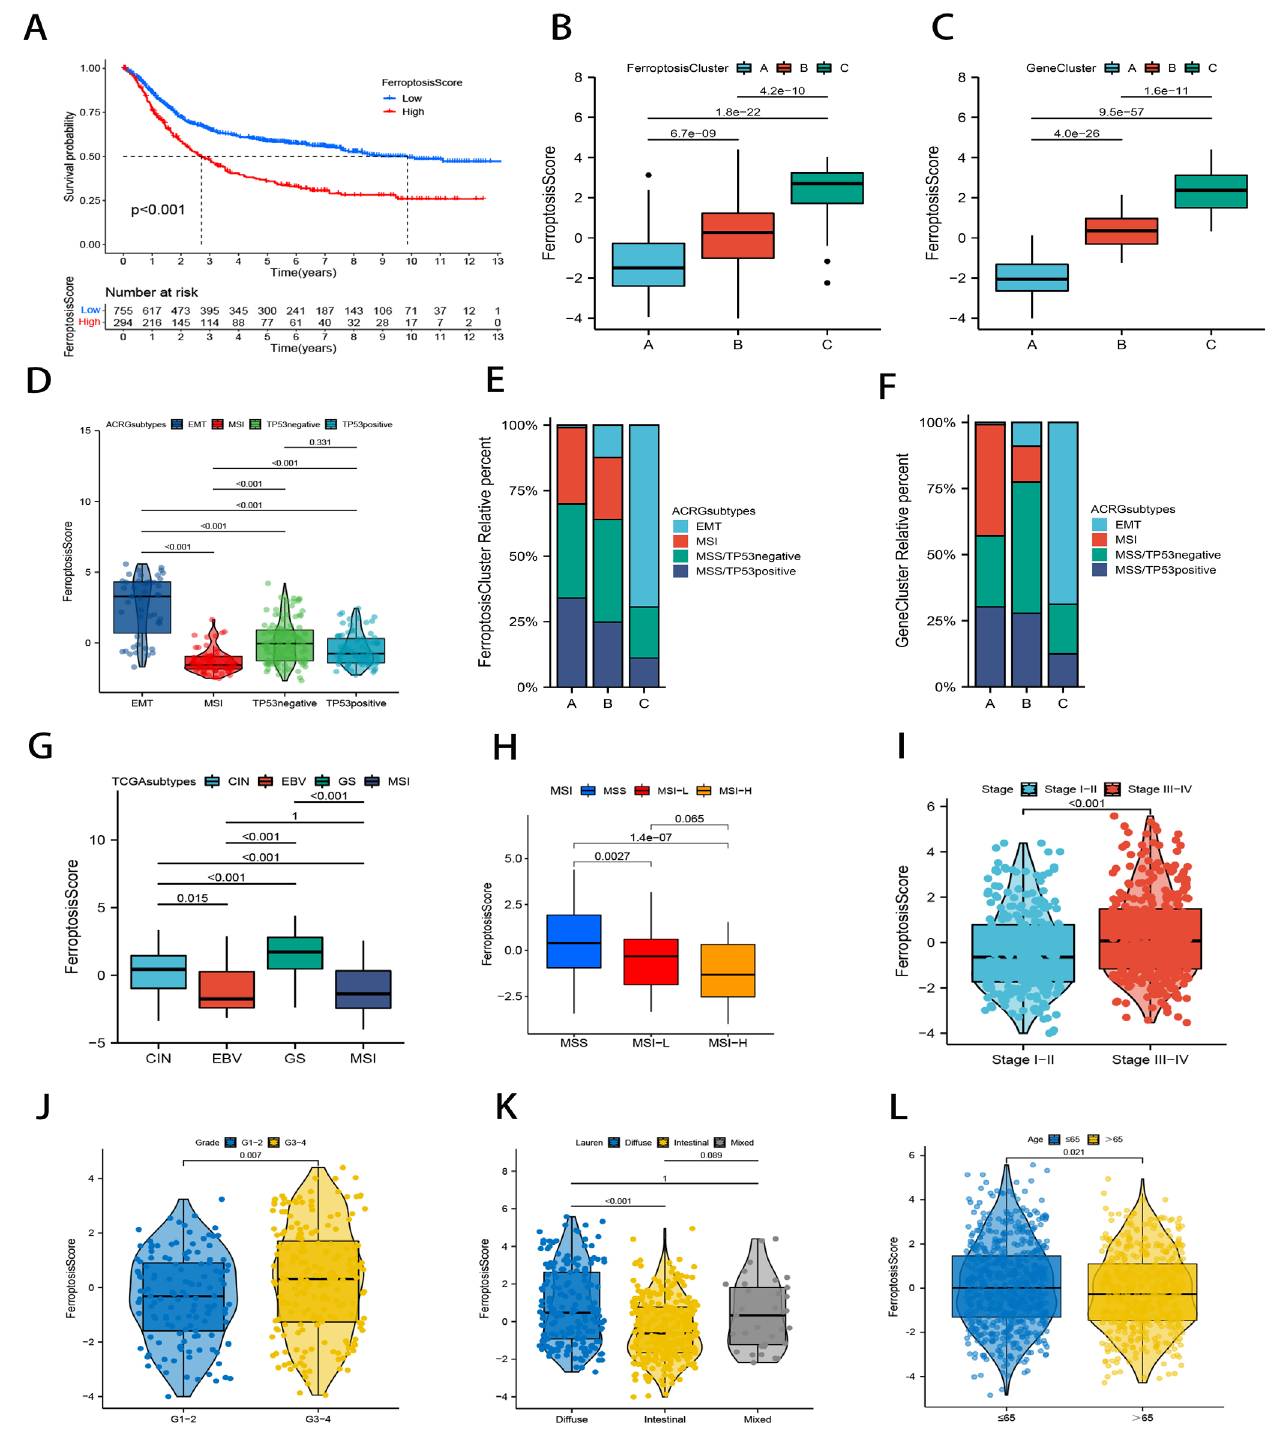
Figure 5. Correlation study of ferroptosis scores and clinical characteristics in GC patients. ( A ) Kaplan–Meier survival curves for the ferroptosis score group. ( B , C ) Differences in ferroptosis scores in the ferroptosis cluster ( B ) and gene cluster ( C ). ( D ) Differences in ferroptosis scores between ACRG types. ( E , F ) ACRG type distribution in ferroptosis clusters ( E ) and gene clusters ( F ). ( G ) Differences in ferroptosis scores for TCGA types. ( H – L ) Relationship between ferroptosis scores and clinical features such as MSI ( H ), stage ( I ), grade ( J ), Lauren pathological classification ( K ), and age ( L ).